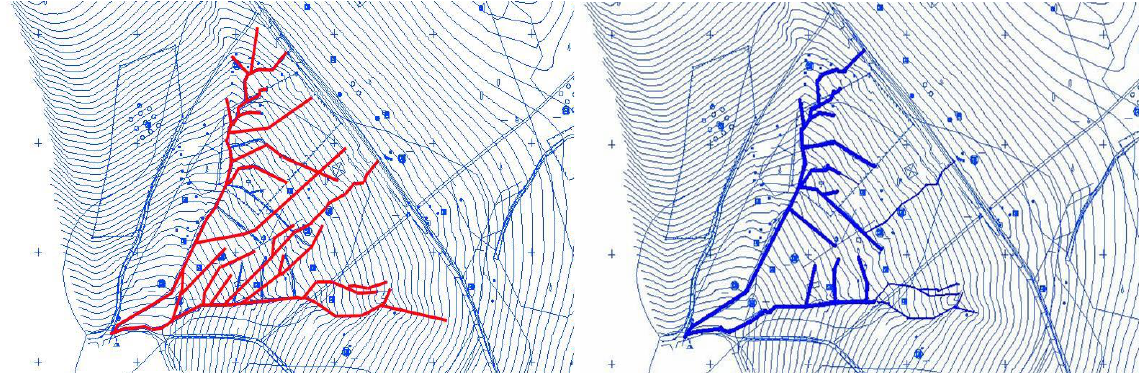
Figure 2. Details of the stream network caused by machinery before ( left ) and after its target regulation in 1996 ( right ).